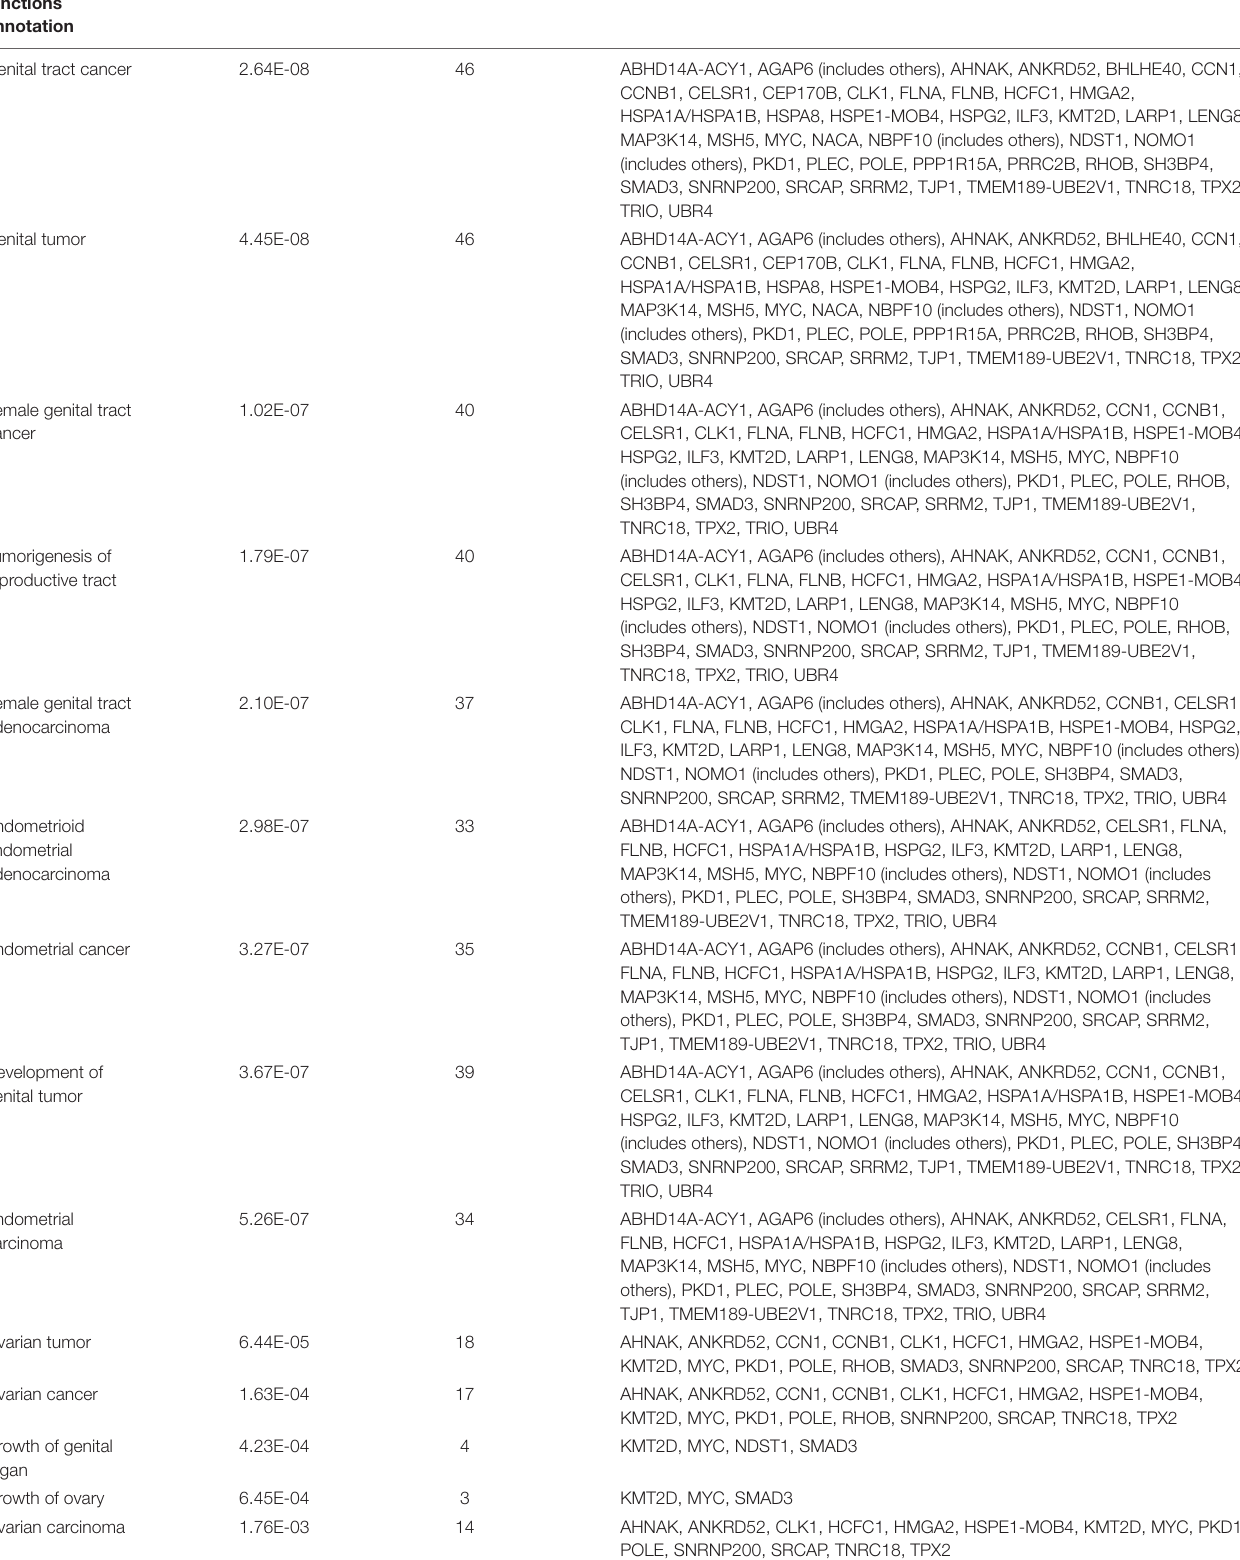
TABLE 8 | Female reproductive diseases caused by radiation